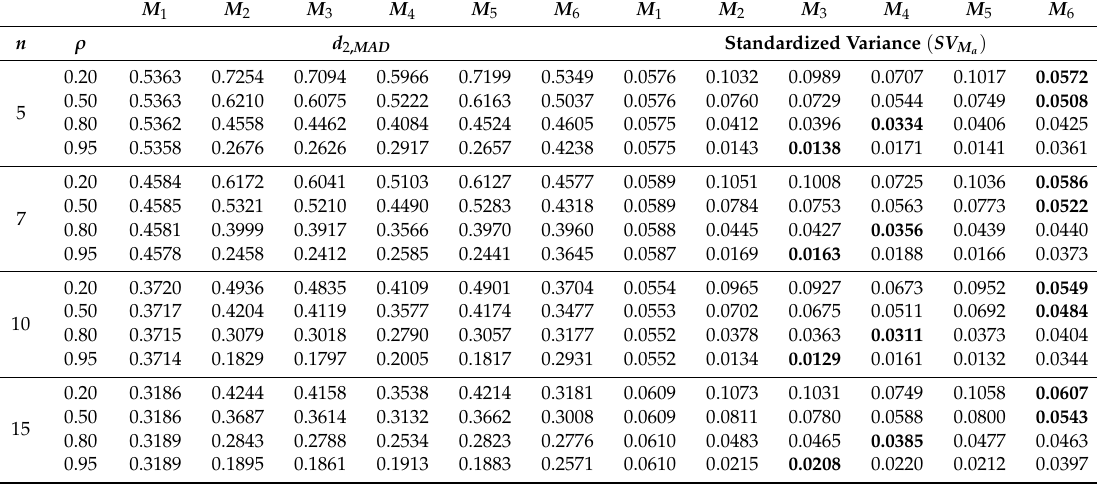
Table 1. d 2, MAD and standardized variance for di ff erent median